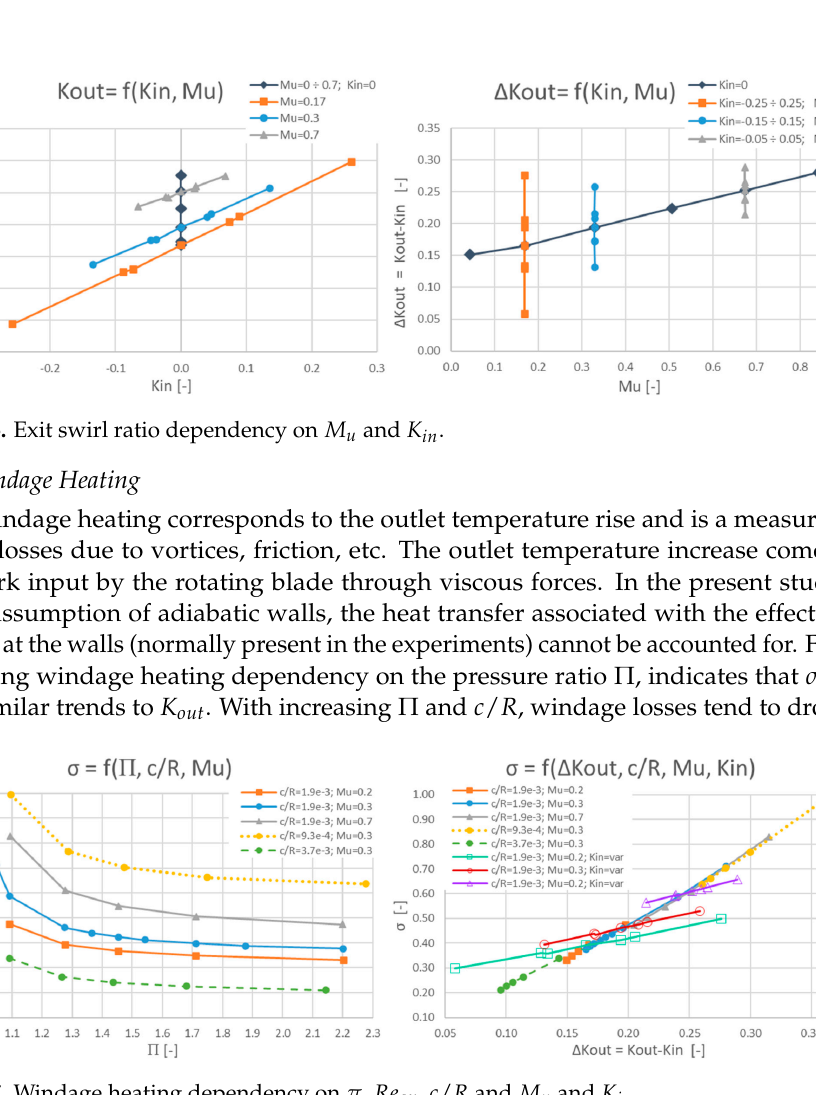
Figure 7. Windage heating dependency on π , Re ax , c / R and M u and K in